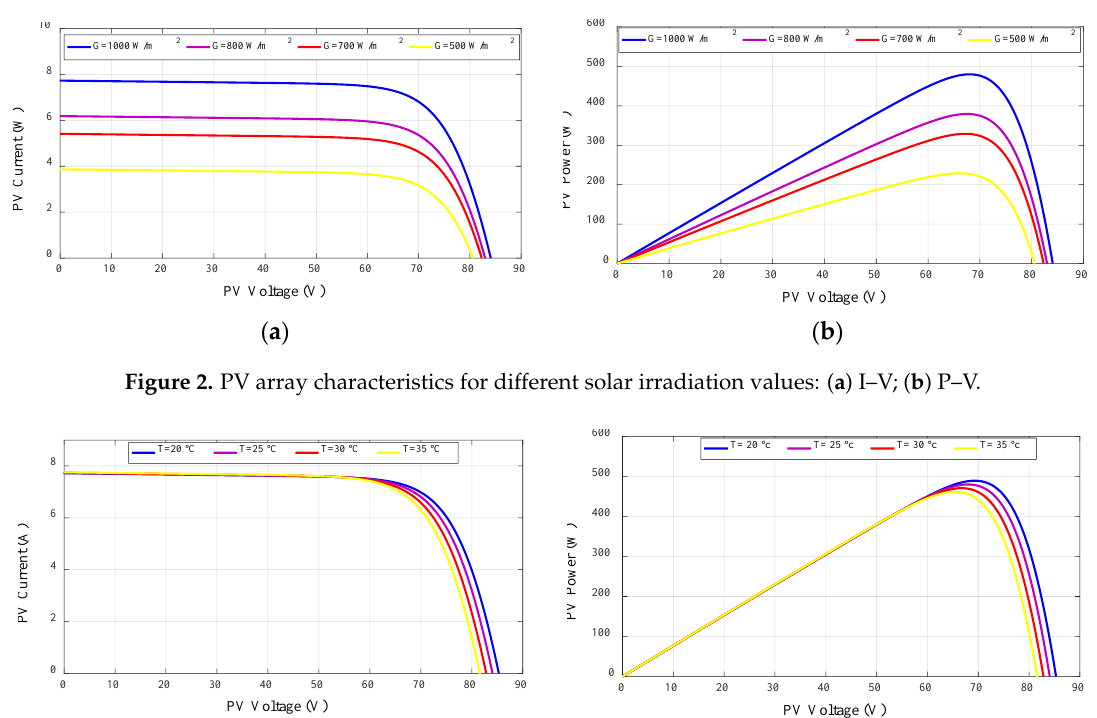
Figure 3. PV array characteristics for different temperature values: ( a ) I–V; ( b ) P–V.